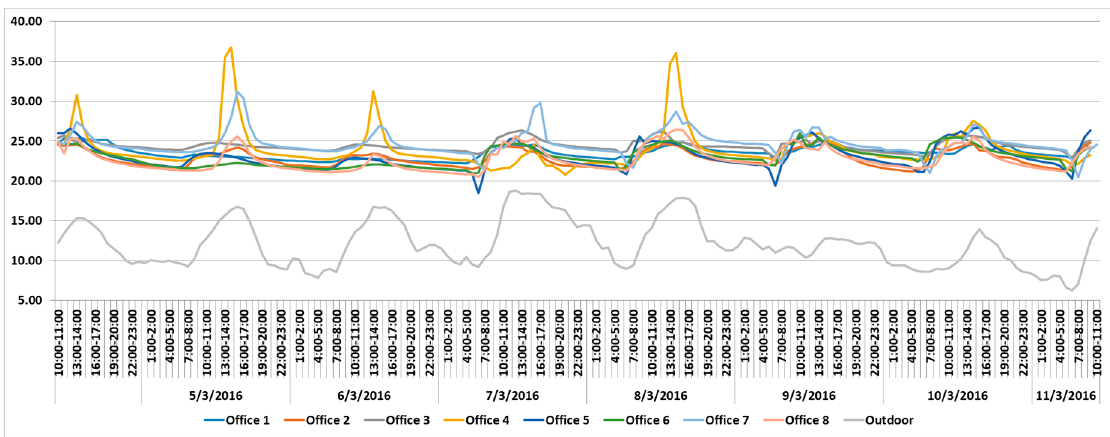
Figure 6. Temperature levels of the external and all the indoor environment of Building C during winter.